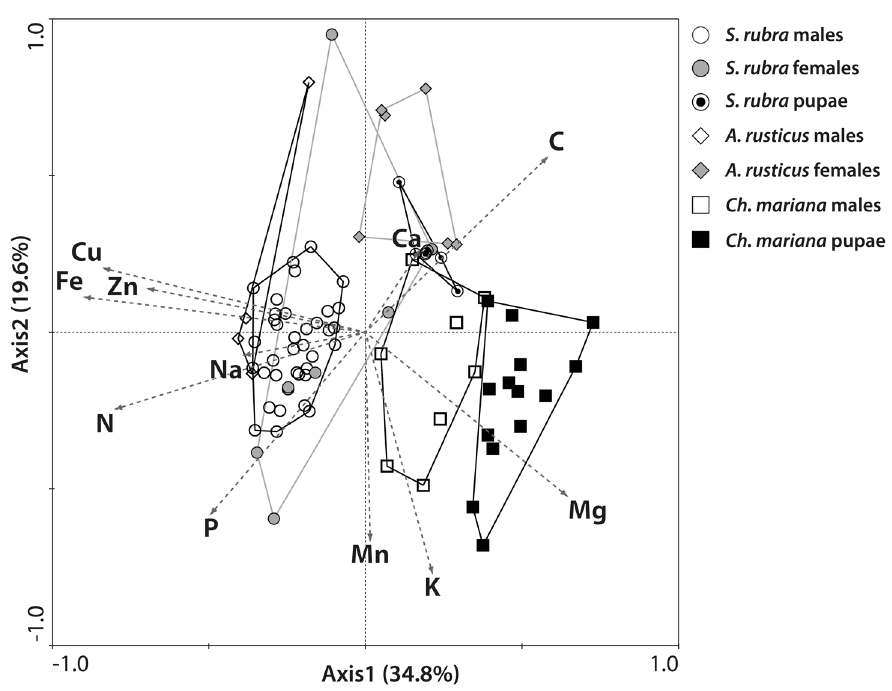
Fig. 2. Multivariate analysis of stoichiometric relations in three species of xylophagous beetles based on the 11 studied elements – PCA plot (first two axes).